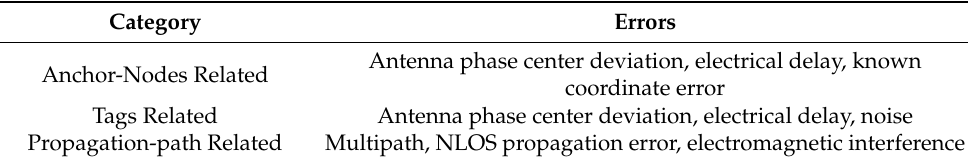
Table 1. Errors of UWB Indoor